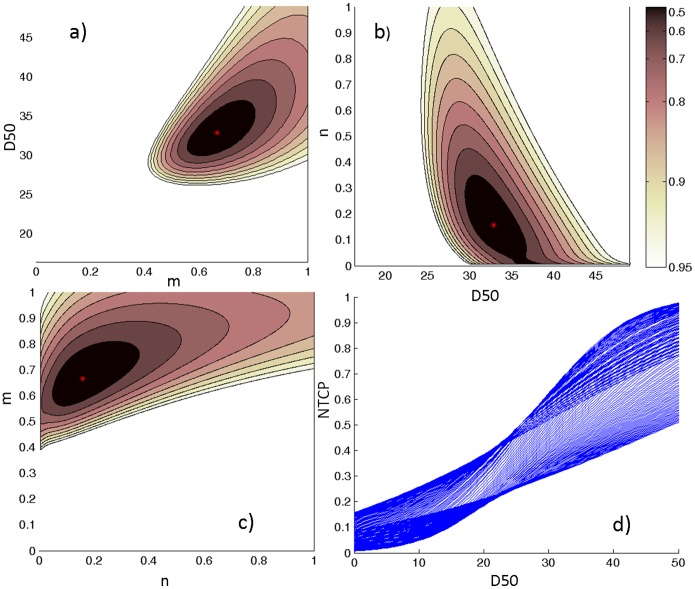
Likelihood estimation values plotted as a function of heart LKB parameters.a) m and D50 for a fixed value of n = 0.16; b) D50 and n for a fixed value of m = 0.67; c) n and m for a fixed value of D50 = 32.8; d) NTCP bundle of curves showing 95% confidence interval region for the model fit. The red point corresponds to the optimum LLH. Abbreviation- LKB: Lyman-Kutcher-Burman, D50: uniform dose given to the entire organ volume that results in 50% complication probability, NTCP: Normal Tissue Complication Probability, LLH: Log-likelihood.